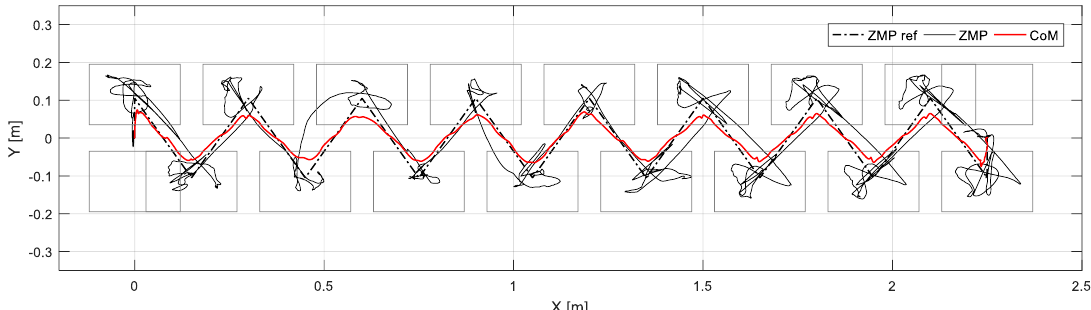
Figure 21. ZMP reference, measured ZMP, and CoM trajectory under varying local and global slopes.